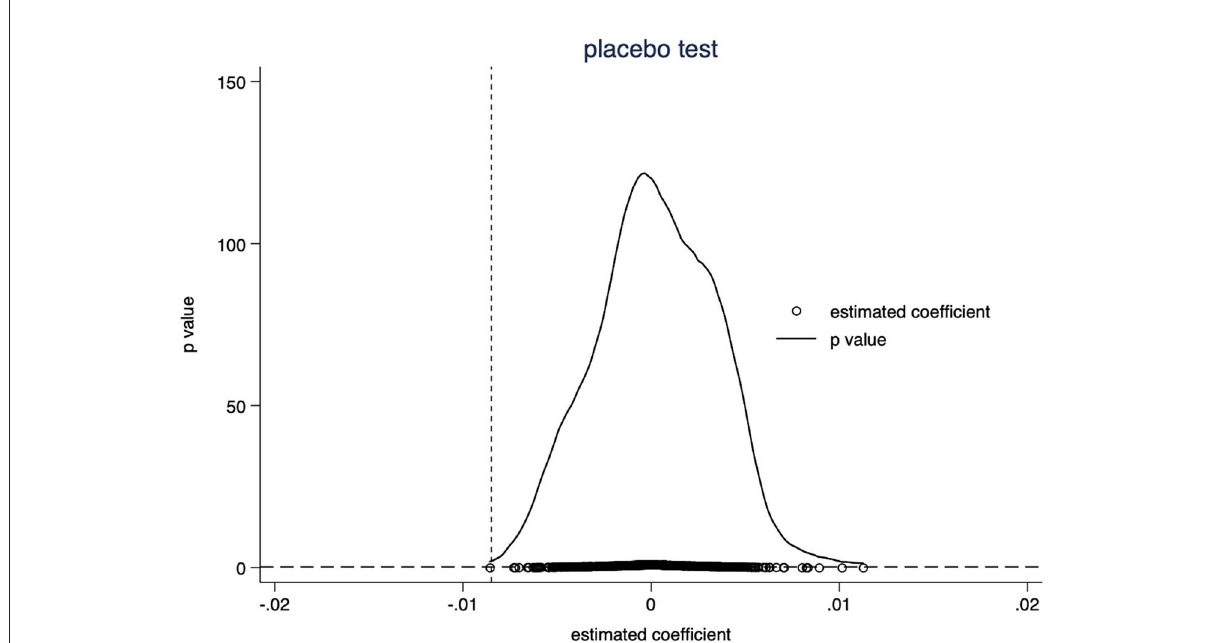
FIGURE3 Placebo test. This figure depicts the distribution of estimated coefficients and corresponding p -values for 500 pseudo-treated samples. The X-axis depicts the estimated pseudo-treatment coefficients. The Y-axis depicts the p -values. The vertical dashed line depicts the natural treated effect of − 0.008. The horizontal dashed line depicts the 10% significant level. As illustrated in the figure, the estimated coefficients are predominantly near zero, and the majority of estimated values have p -values greater than 0.1 (not significant at the 10 percent